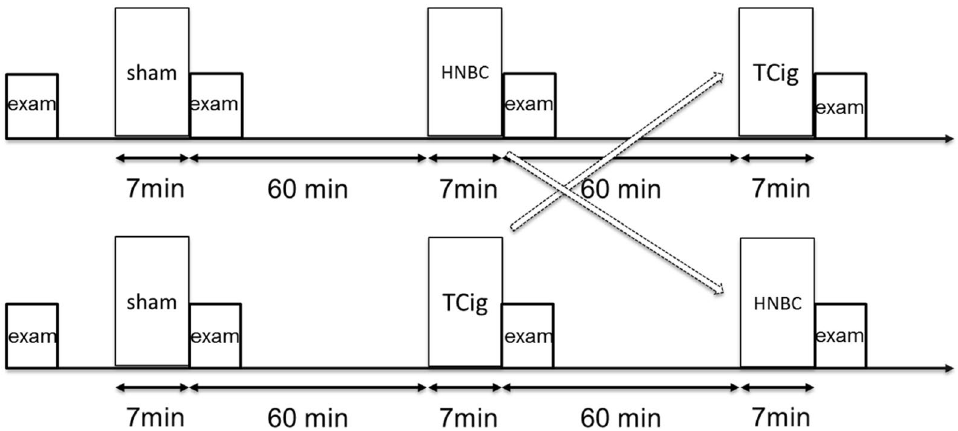
Figure 5. Acute phase protocol. Following an initial sham smoking session, subjects were randomised to either a heat-not-burn or traditional cigarette smoking session; following a washout period of 60 min, they were crossed-over to the alternative smoking session. Each session was followed by a vascular stiffness examination and blood-sampling for oxidative stress and platelet activation assessment. Exam examination, HNBC heat-not- burn cigarette, TCig tobacco